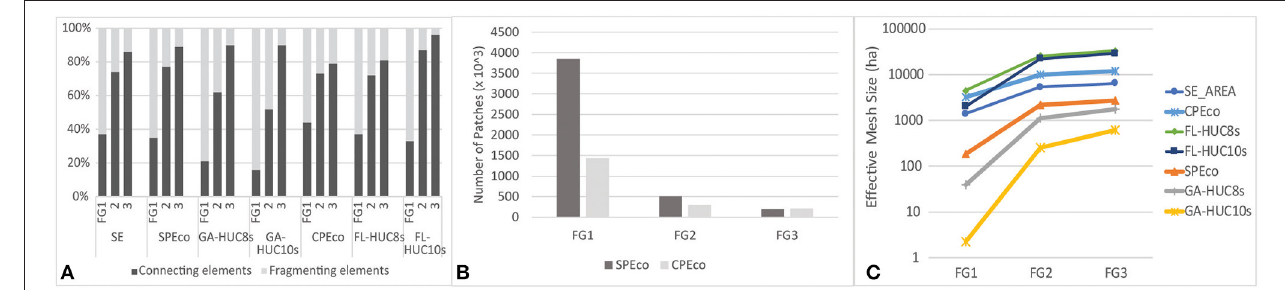
FIGURE 5 | Landscape ecological indices of connectivity and fragmentation for three fragmentation geometry (FG) levels. (A) Proportion of total mean HUC-12 area of connecting vs. fragmenting elements for each study area and for each FG level. (B) Graph of number of patches by ecoregion. (C) Graph of effective mesh size (m eff ). Tabulated data provided in Supplementary Table 1.6